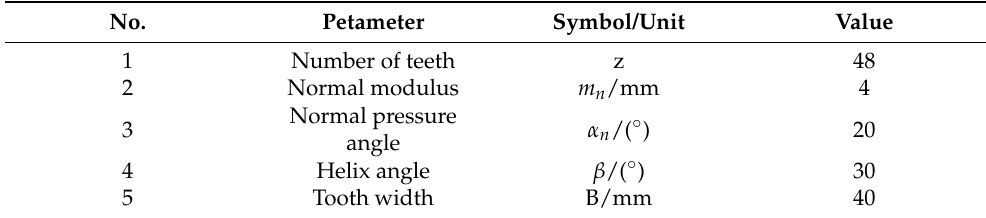
Table 3. Basic parameters of the test gear.